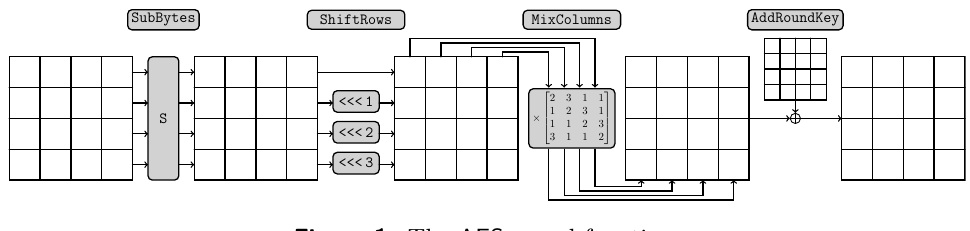
Figure 1: The AES round function.